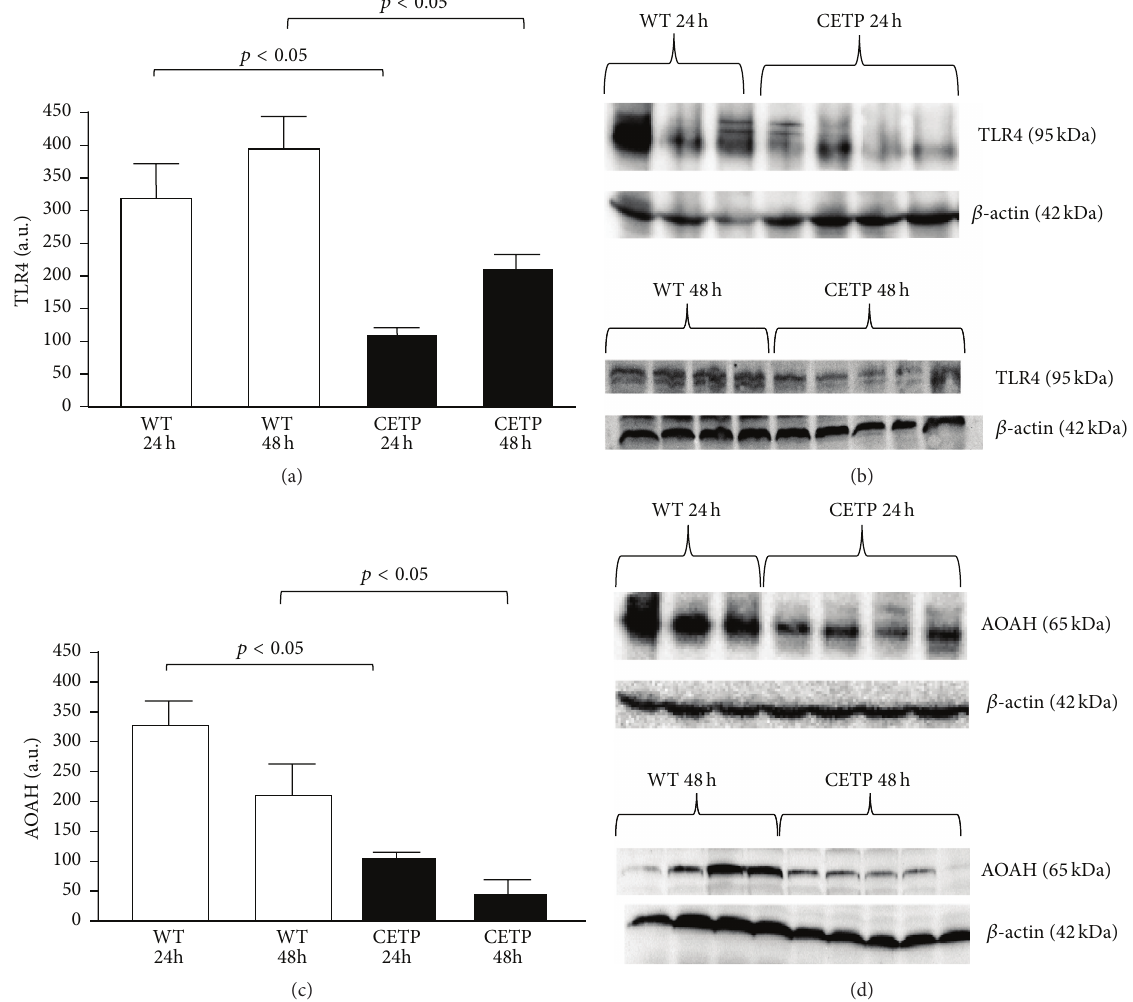
Figure 3: The hepatic content of TLR4 and AOAH decreased in the liver from CETP as compared to WT mice. Liver samples were harvested at 24 h and 48 h after CLP. TLR4 ((a) and (b)) as well as AOAH ((c) and (d)) protein expression was determined by Western blotting. Graph presented as mean ± SD of arbitrary units corrected by 𝛽 -actin level ((a) and (b)); 𝑛 = 3–5, differences by one-way ANOVA, and 𝑝 < 0.05 . ((b) and (d)) Representative Western blot images of TLR4, AOAH, and 𝛽 -actin protein